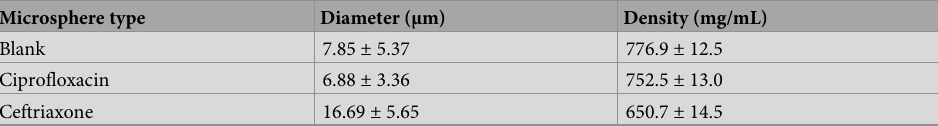
Table 1. Average diameter and density of microspheres.